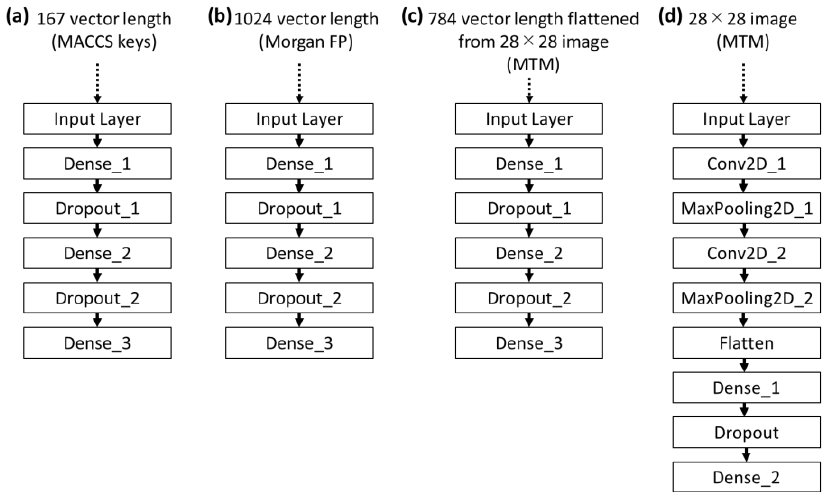
Figure 5. DNN and CNN architectures. ( a ) DNN model using MACCS keys. ( b ) DNN model using Morgan FP. ( c ) DNN model using flattened MTM. ( d ) CNN model using MTM. Dense_X is a fully-connected layer. Dropout_X is a layer where randomly selected neurons are ignored during training. Flatten is a layer that converts a matrix into a single array. Conv2D_X is a convolution layer. MaxPooling2D_X is a pooling layer. X denotes identification number of a layer.